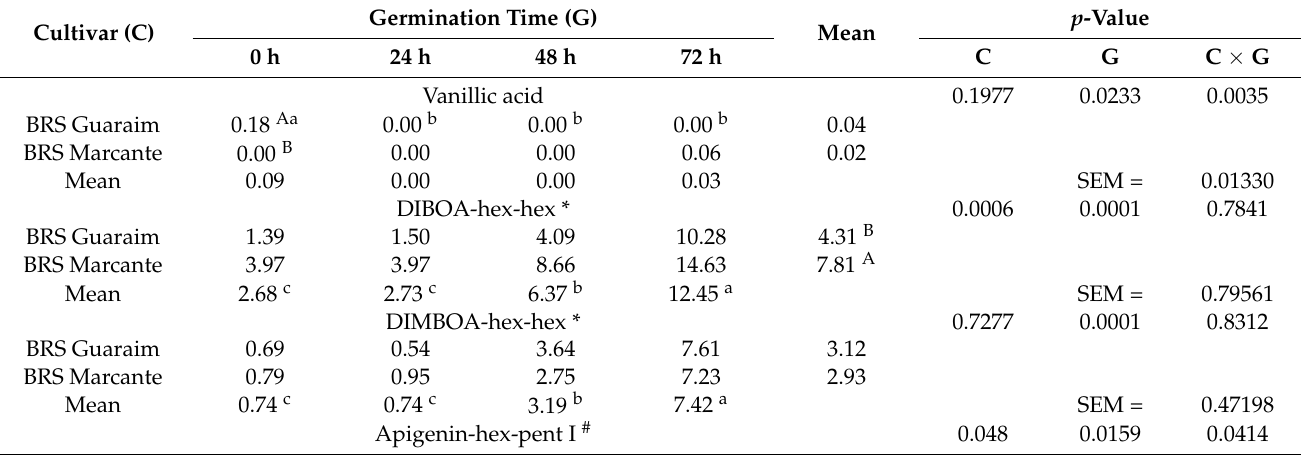
Table 2. Changes in free phytochemical compounds (mg · 100 g − 1 whole wheat flour d.b.) of wheat grains according to the germination time (G) and cultivar